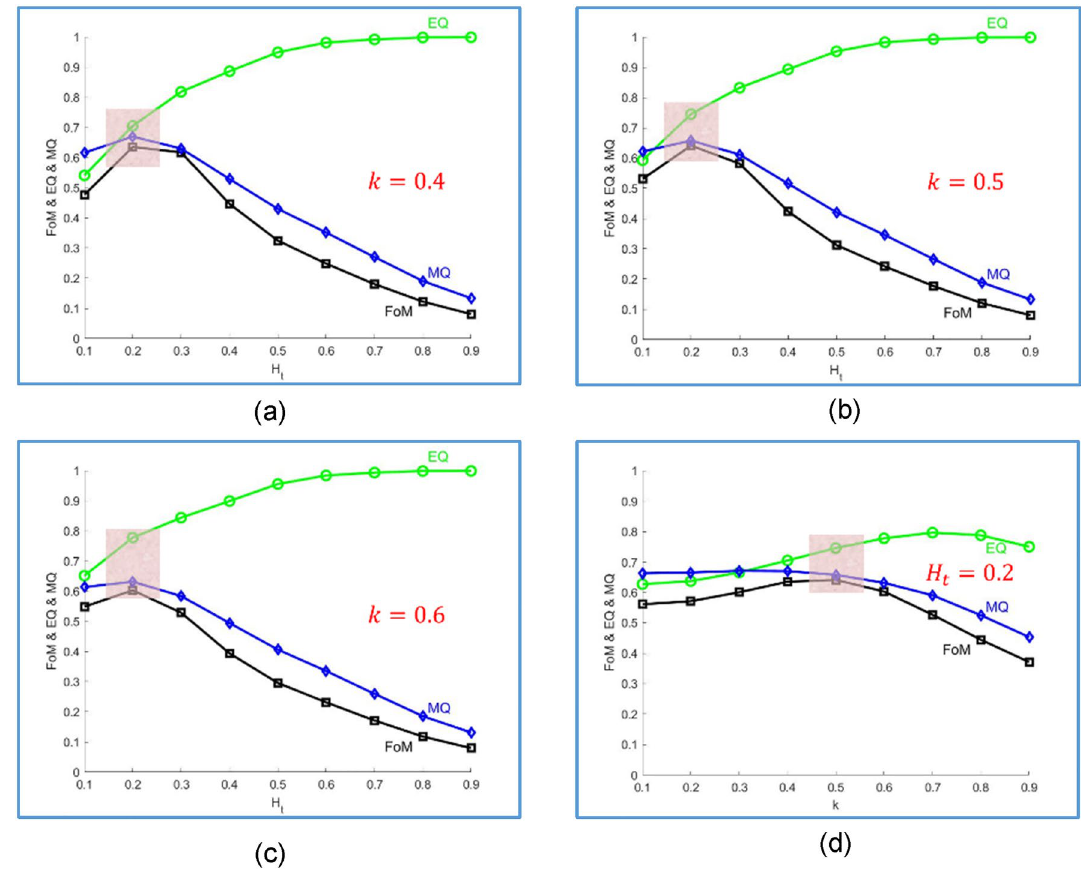
Figure 9. Performance indicators for ( a ) k = 0.4 , ( b ) k = 0.5 , ( c ) k = 0.6 , ( d ) H t = 0.2